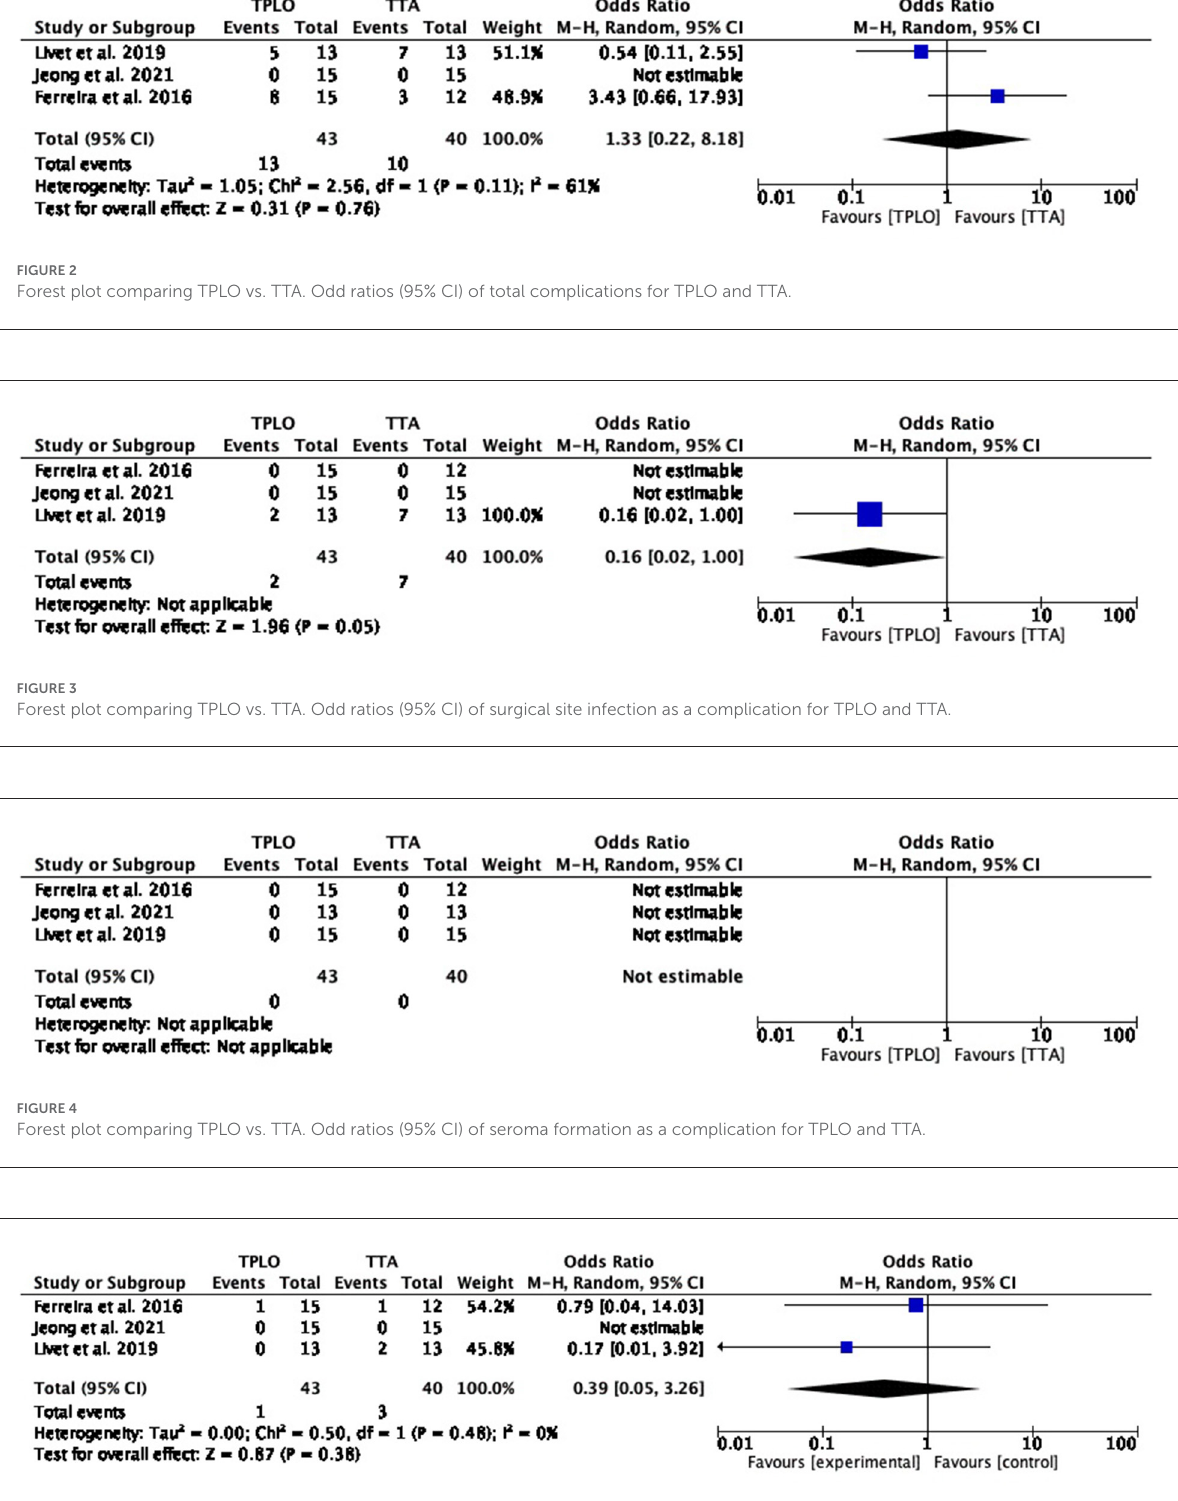
FIGURE5 Forest plot comparing TPLO vs. TTA. Odd ratios (95% CI) of implant failure as a complication for TPLO and